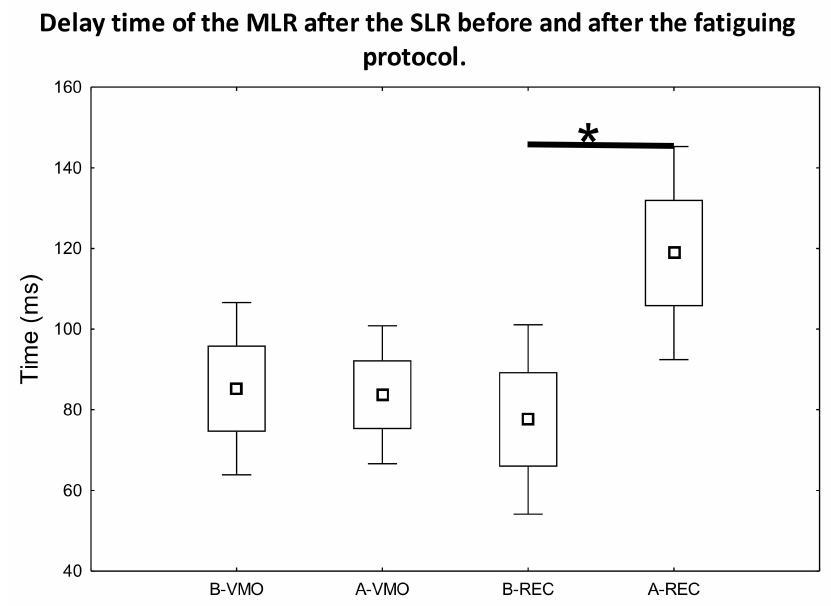
Figure 3. Delay time (ms) of the MLR after the SLR before and after the fatiguing protocol (B- VMO, B-REC measurement data taken on the muscles before fatiguing protocol; A-VMO, A-REC measurement data after fatiguing protocol). Box: mean ± SE; whiskers: mean ± 2SE. * indicates significant difference between B-REC and A-REC ( p < 0.05). No significant difference could be observed between B-VMO and A-VMO ( p > 0.05).